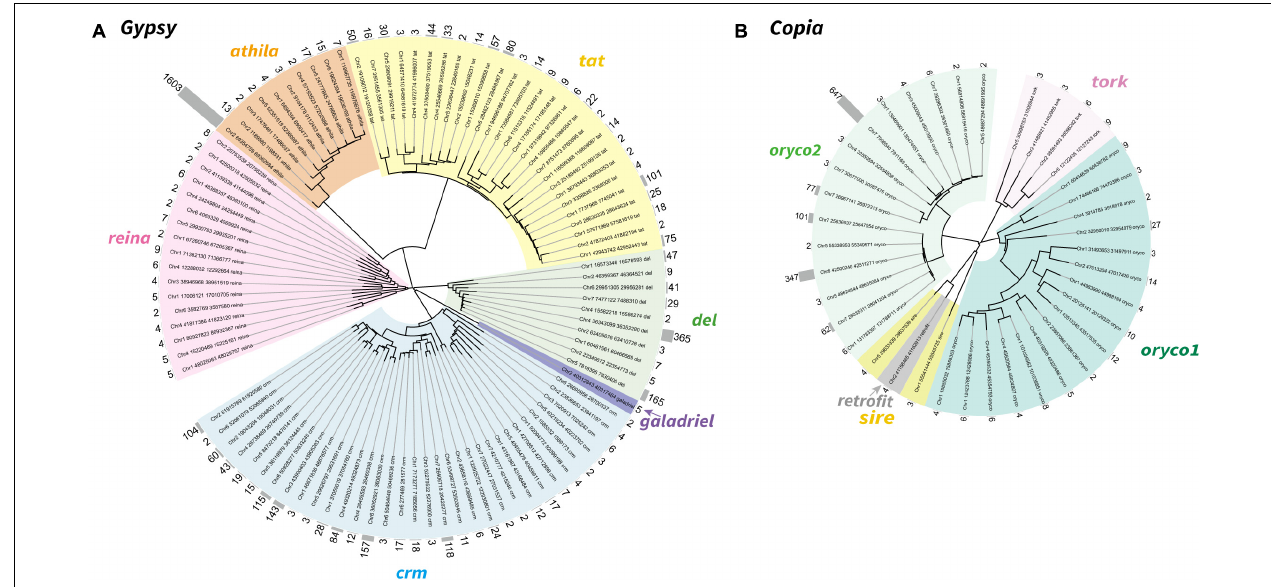
FIGURE 2 | Neighbor-joining phylogeny of the LTR-RTs Gypsy (A) and Copia (B) superfamily in T. arvense . Different lineages were shown in clades marked in different colors. Each branch represents an LTR-RT family. The gray histogram indicates the copy number of each family (counted based on reverse transcriptase domains).